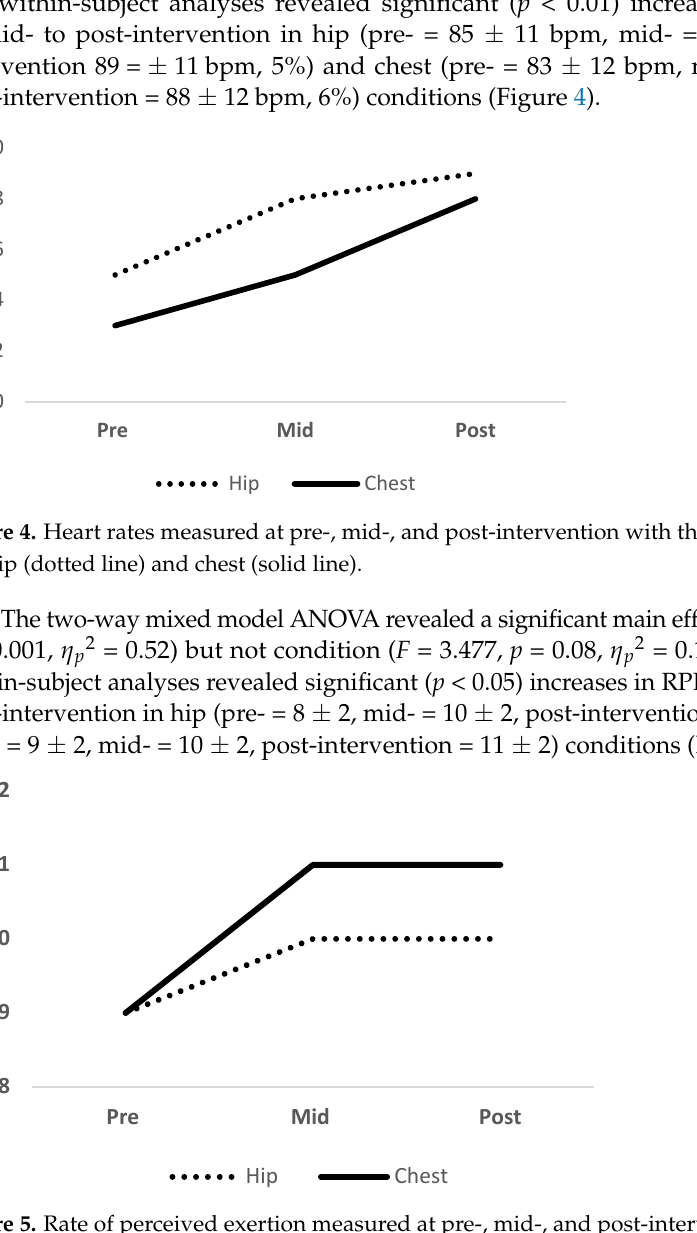
Figure 5. Rate of perceived exertion measured at pre-, mid-, and post-intervention with the elastic band placed at the hip (dotted line) and chest (solid line).